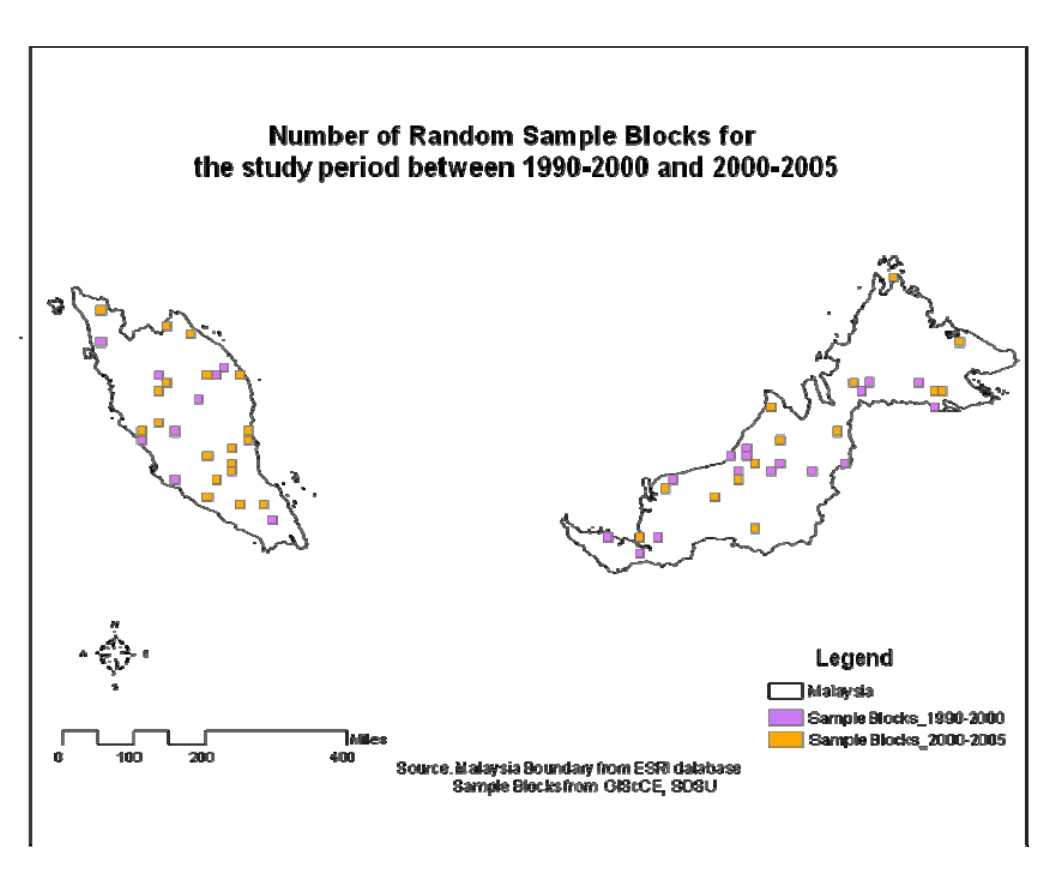
Figure 1. Locations of the sample blocks for 1990–2000 and